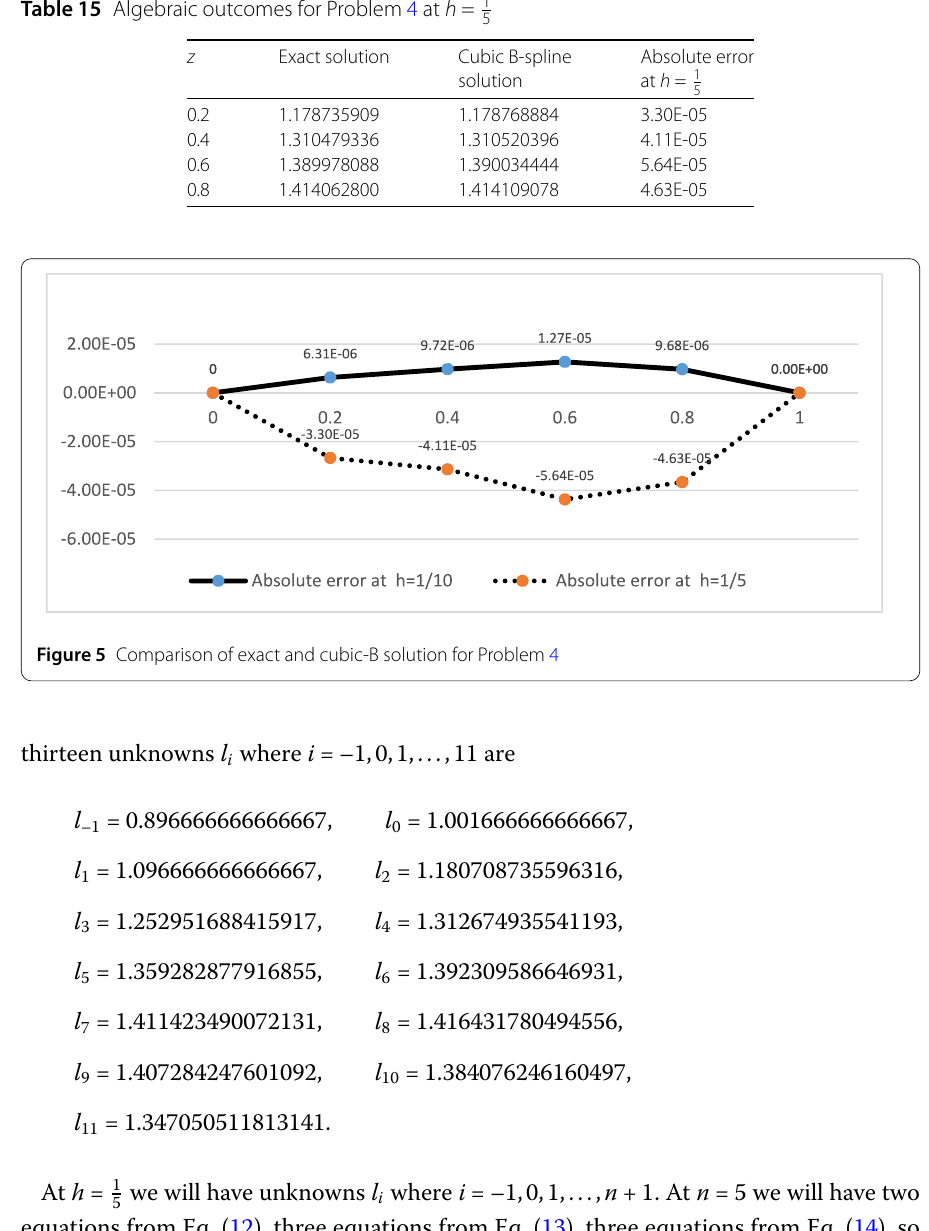
Table 15 Algebraic outcomes for Problem 4 at h = 1